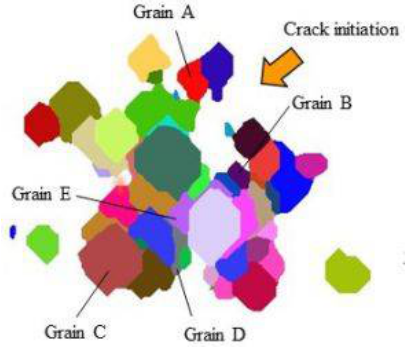
Figure 4. Cross section of specimen at crack initiation site.